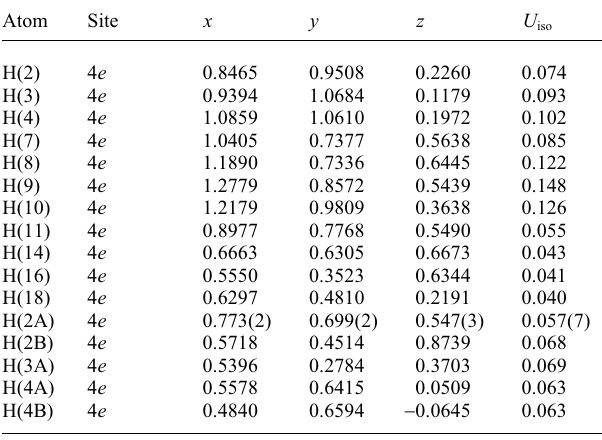
Table 2. Atomic coordinates and displacement parameters (in Å 2 )